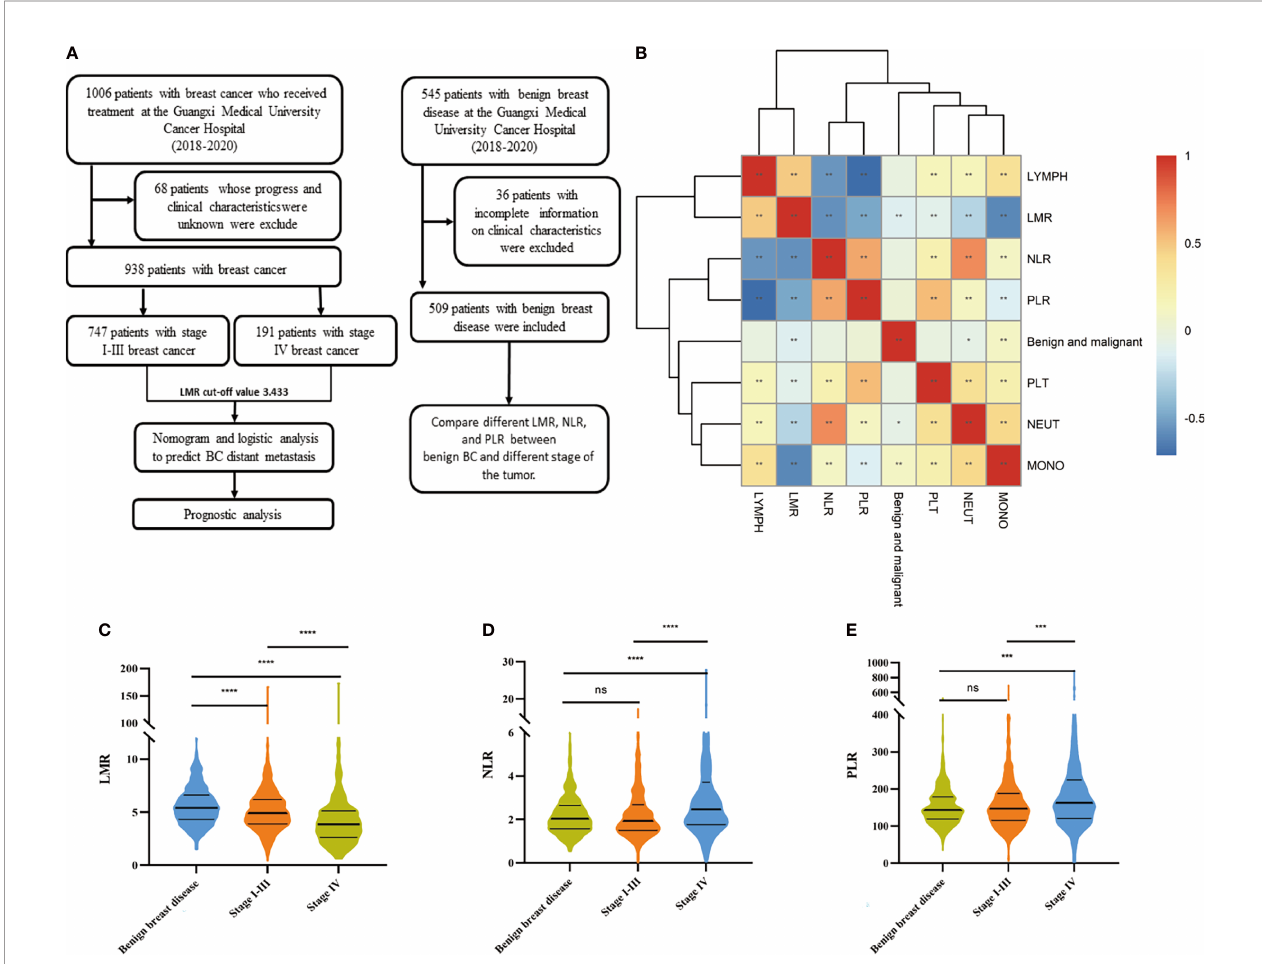
FIGURE 1 | Working mode and Distribution of LMR and other indicators in benign breast diseases and tumors. (A) The work fl ow of this study. (B) Visualization of the correlation matrix of hematology test indicators and benign and malignant tumors, showing that MONO, NRUT, and LMR are related to tumor malignancy. Boxplot of (C) LMR (D) NLR and (E) PLR in benign BC and different stages of the tumor. Differences between groups estimated by Mann – Whitney U as appropriate. (*P < 0.05, **P < 0.01, ***P < 0.001, ****P < 0.0001, ns P >